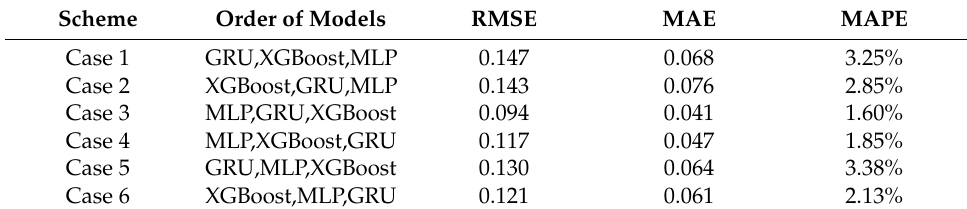
Table 5. Impact of model order on